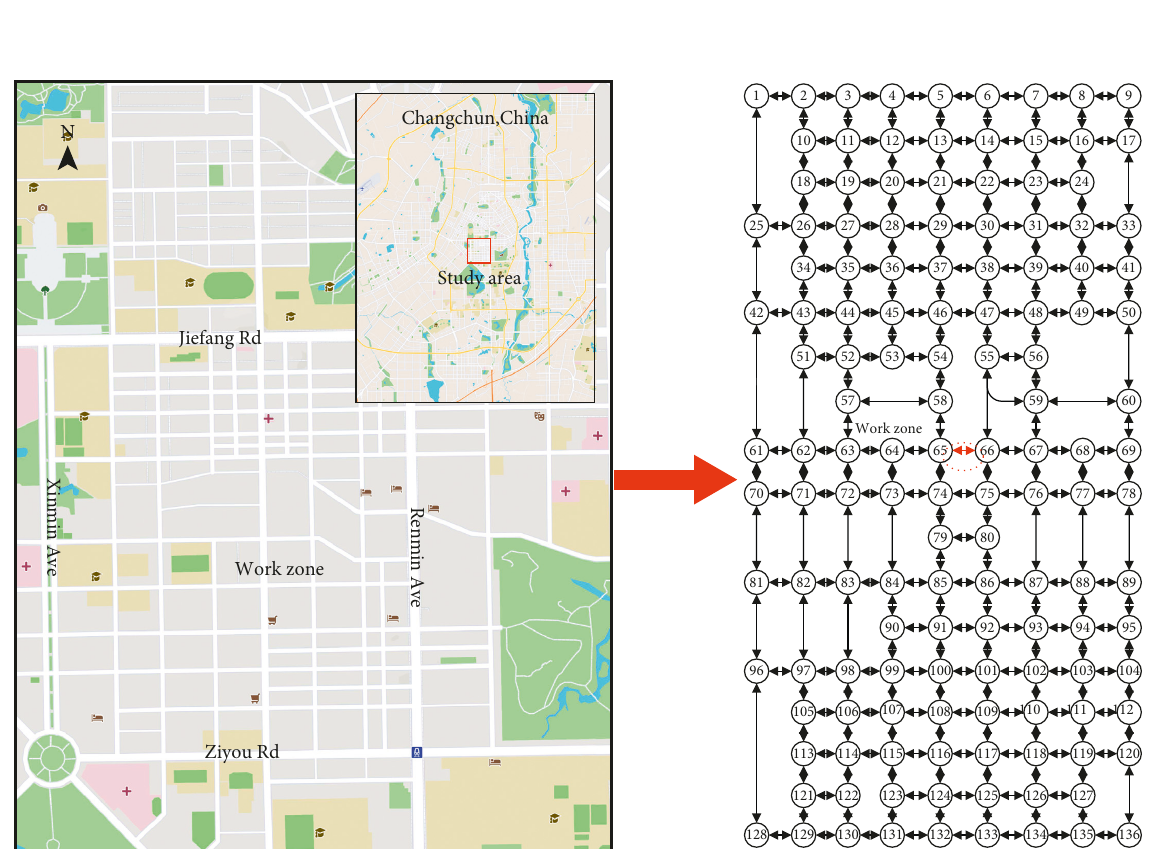
Figure 5: Case study work zone in the Guilin